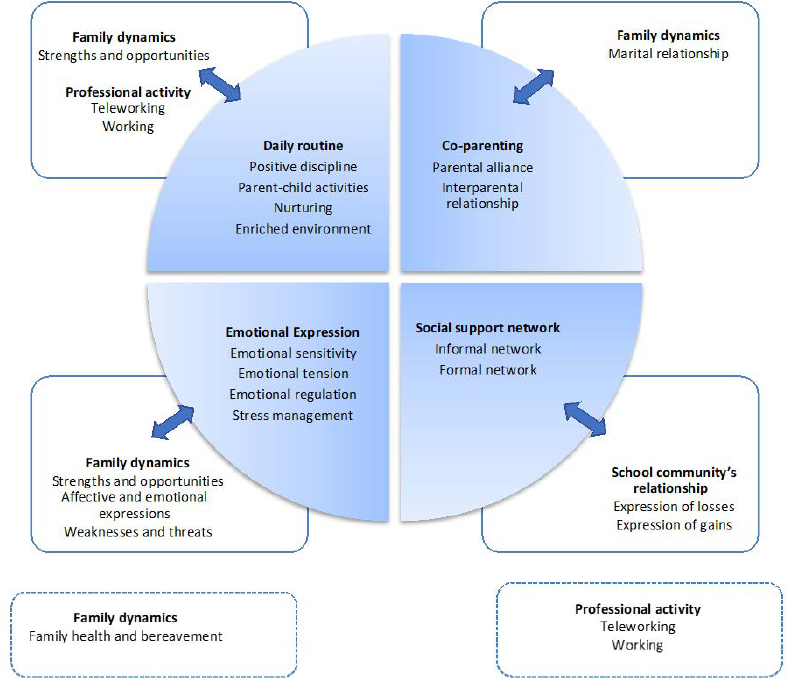
Figure 1. Comparison of the parenting scales and subscales of the survey, and the thematic axes and categories from the content analysis of the